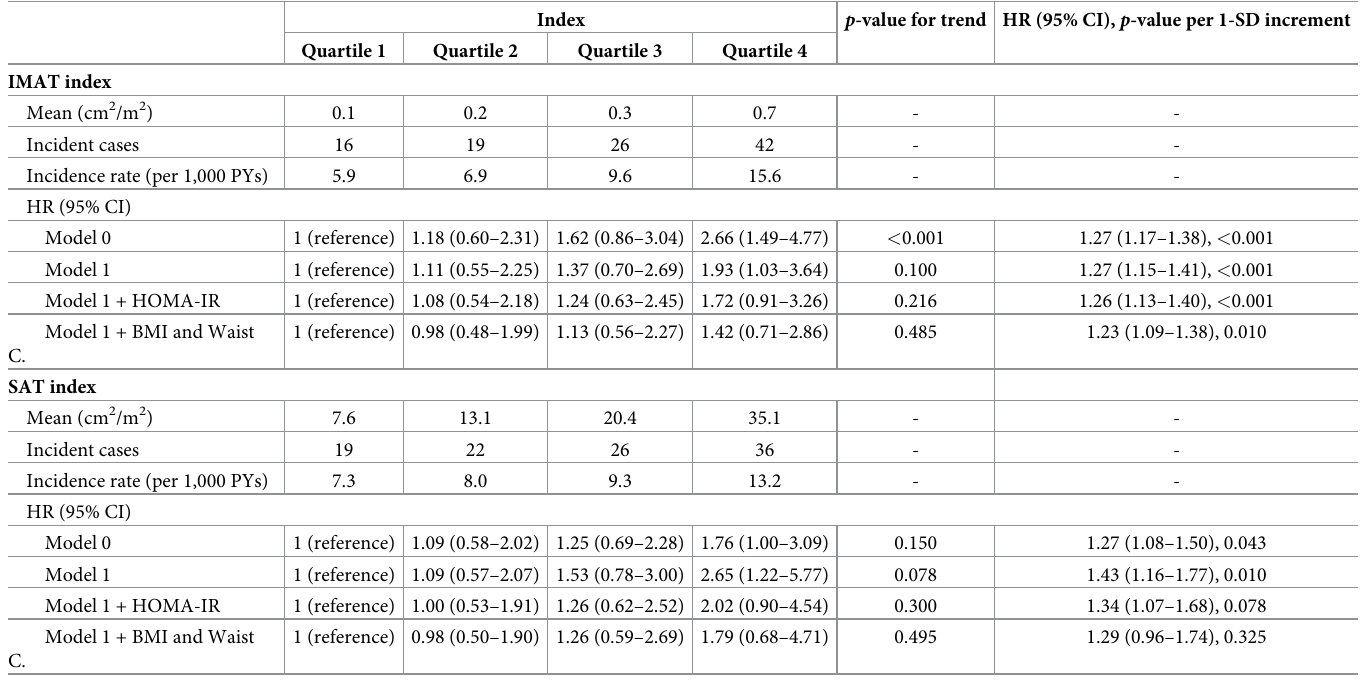
The generalized additive Cox proportional hazard models showed little evidence for a non- linear association between PM density and T2D incidence ( S6 Fig ). The models adjusted for Table 2. Associations of adipose tissue biomarkers and T2D